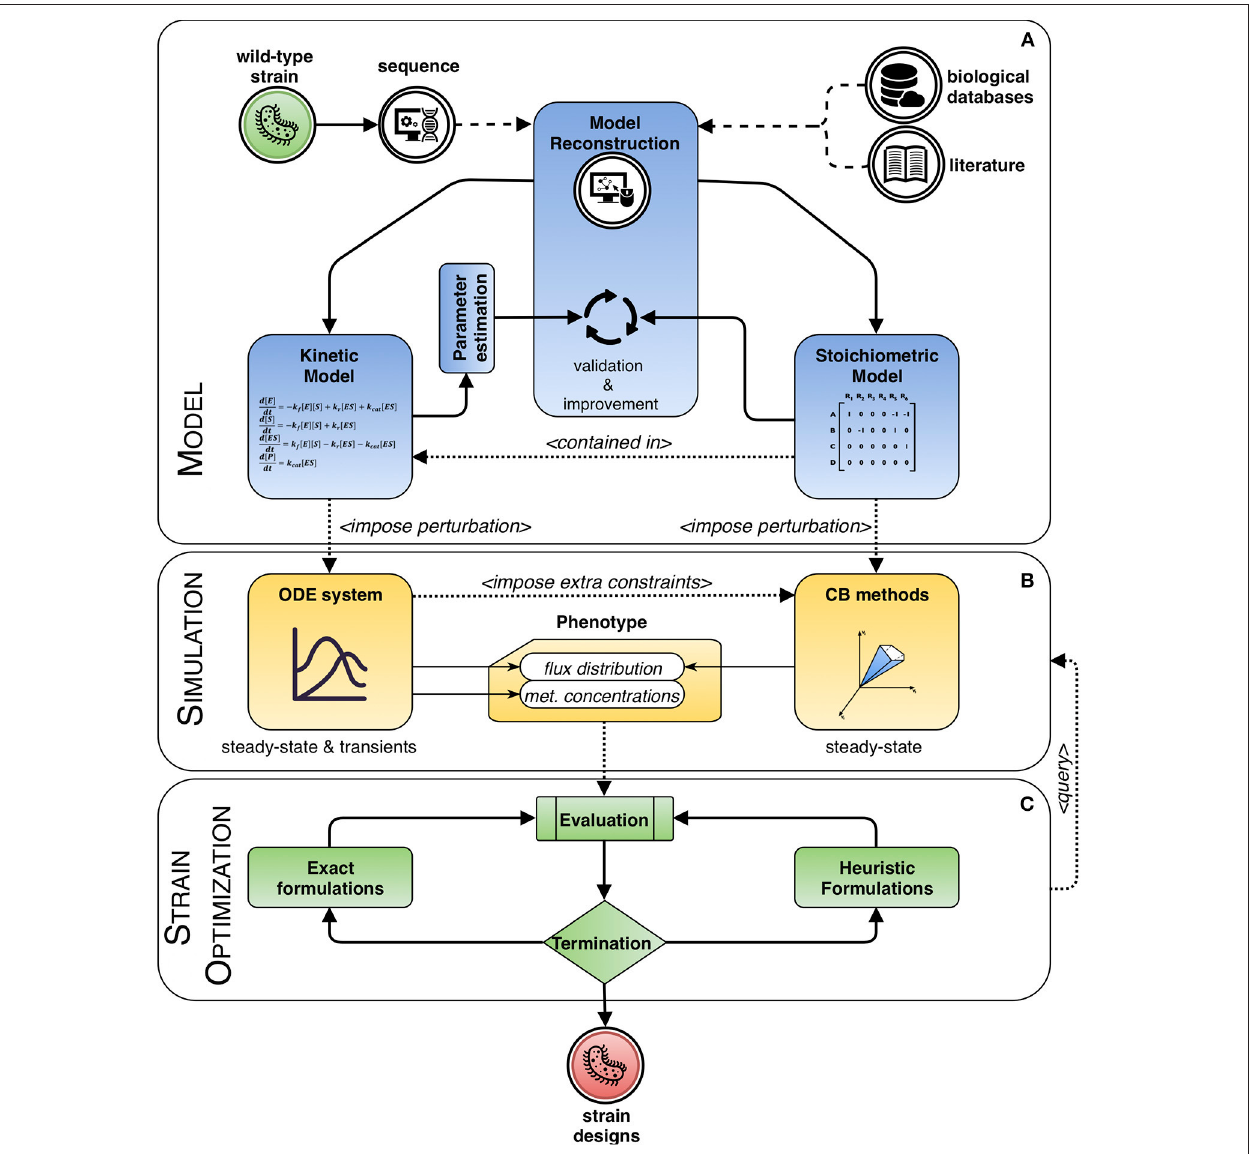
FIGURE 1 | Modeling framework based on dynamic systems. The process of engineering a wild-type strain starts by reconstructing a model from its genome sequence complemented with information extracted from biological databases and literature. Then, the process can be divided in three main interacting blocks. (A) Model: it can include stoichiometric information only, or a combination with kinetics, whose parameters need to be estimated. Both types are validated and improved within an iterative process of curation. (B) Simulation: the model is used to predict the phenotype of the system. For kinetic approaches, the behavior of the steady and transient states of metabolite concentrations and fluxes are calculated, while with purely stoichiometry approaches, typically, a sensible flux distribution obeying the imposed constraints and optimizing a given biological assumption is sought. This flux distribution can be further delimited, in a hybrid fashion, by using information from the solution of the ordinary differential equation (ODE) system, if available. (C) Strain optimization: the phenotype is evaluated and optimized until meeting a termination criterion. The cycle consists in integrating solutions as perturbations to the model, in the form of changes to the kinetic parameters or to the constraints, so that a new phenotype can be simulated. In the end, a set of candidate designs is